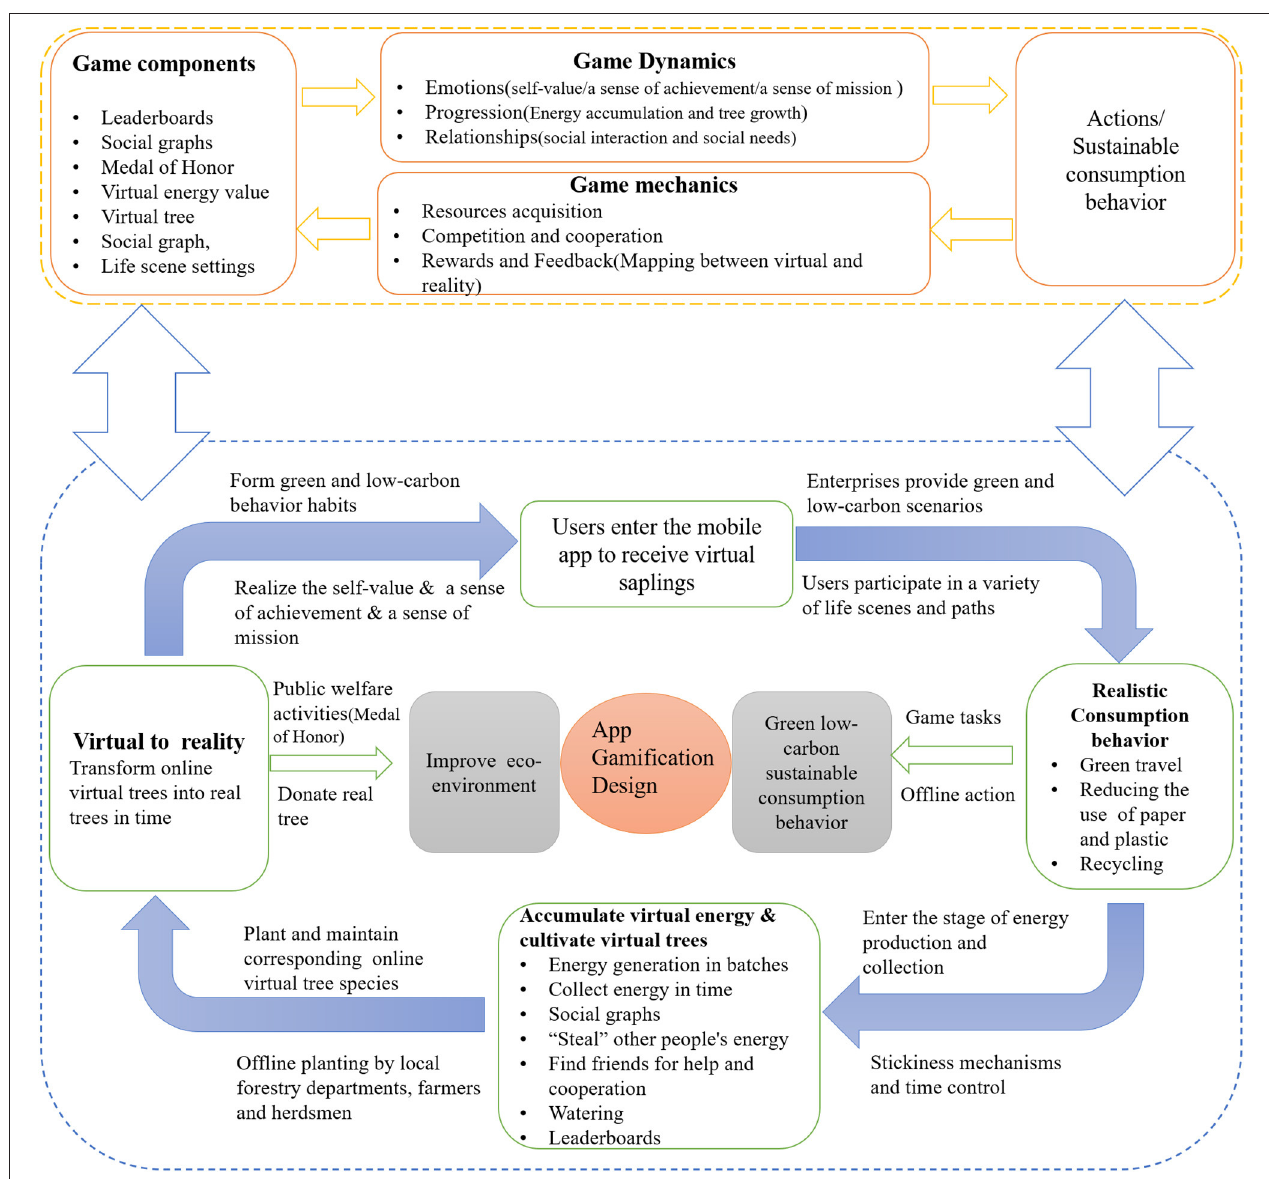
FIGURE 3 | Conceptual model of the incentive mechanism of gamification application for sustainable